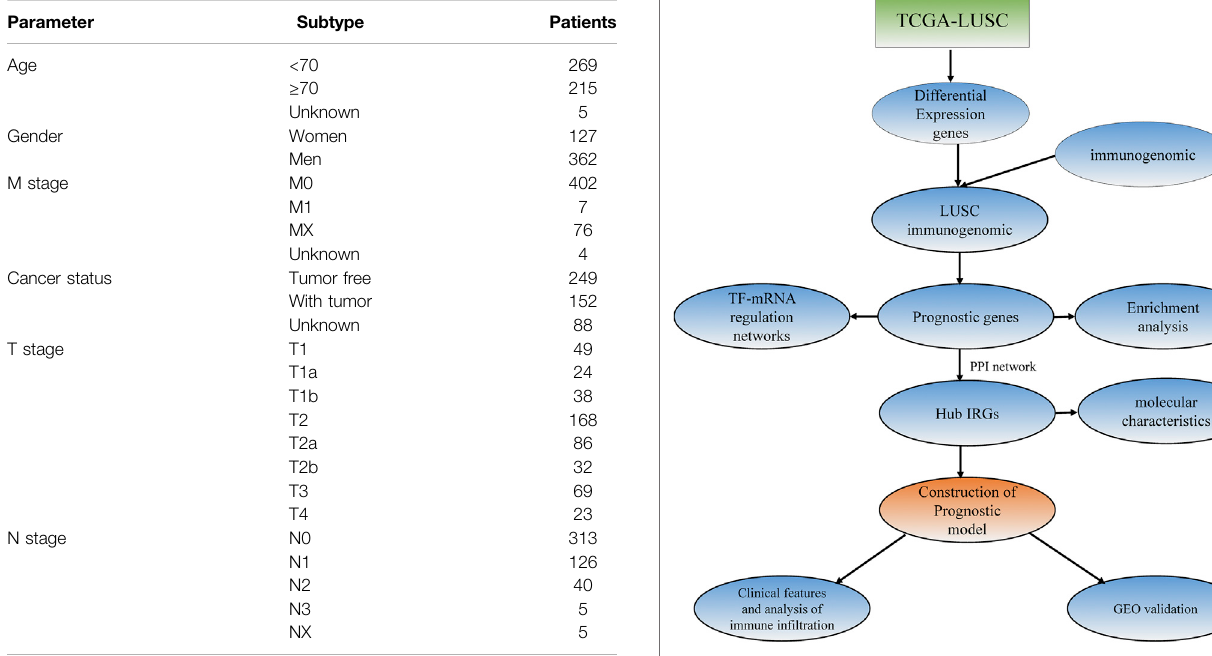
TABLE 1 | Clinical characteristics of TCGA sample.